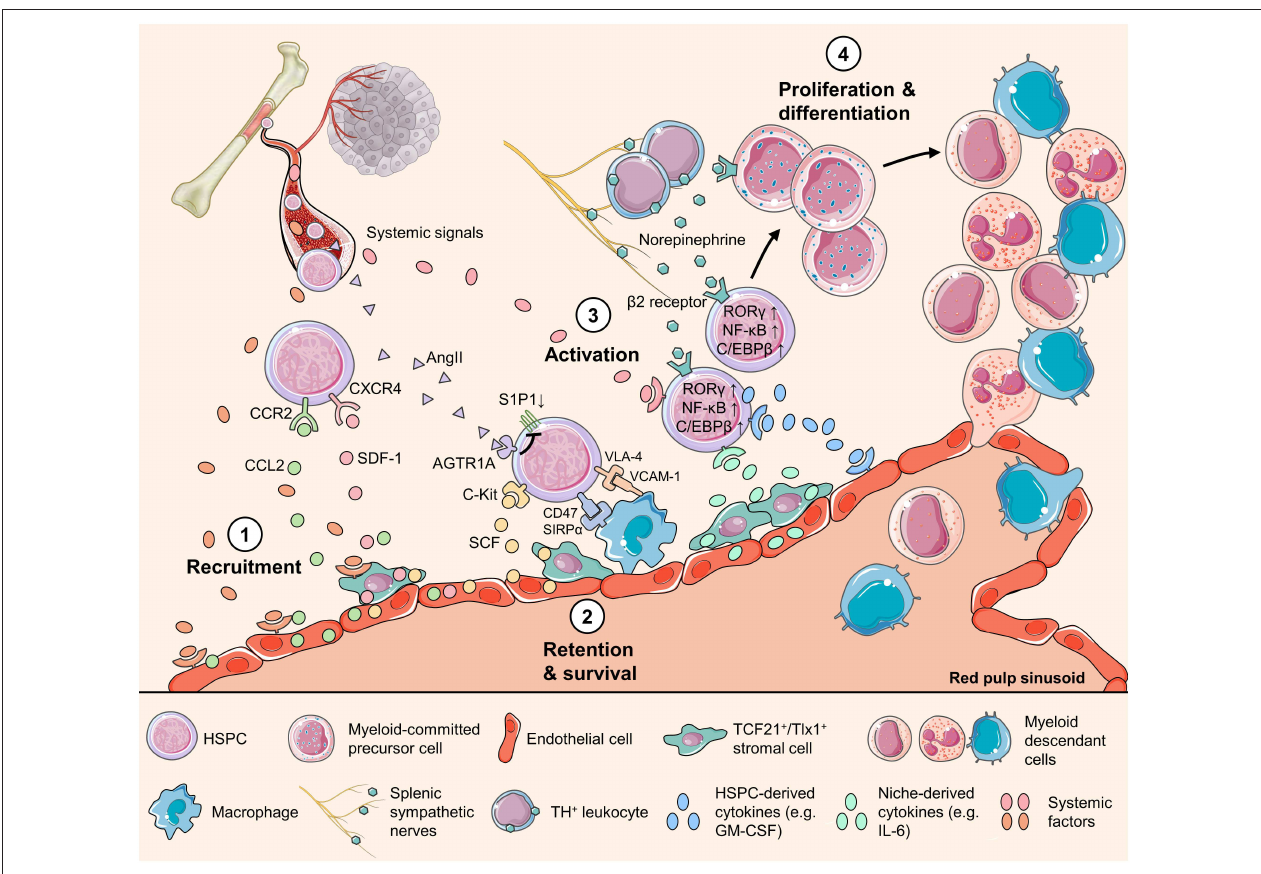
FIGURE 1 | Mechanisms regulating HSPC activity in the spleen. Schematic representation of the HSPC behavior during splenic myelopoiesis, showing multiple cell types and factors of various origins that directly or indirectly regulate HSPC activity. The splenic HSPC response is initiated with (1) increased production of chemokines, such as SDF-1 and CCL2, by endothelial cells and stromal cells around sinusoids. This change of chemokine production might be triggered by systemic factors that convey organismal stress messages. (2) HSPC survival is supported with the key niche-derived cytokine SCF and HSPCs express CD47 to avoid being engulfed by splenic macrophages. In addition, HSPCs express VLA-4 and downregulate S1P1 to maintain in the splenic niche. (3) Activated by systemic, niche-derived, and neural signals, splenic HSPCs upregulate transcription factors including RORC1/ROR γ and C/EBP β to direct myeloid-biased differentiation. Emerging evidence highlights the roles of the HSPC endogenous cytokines such as GM-CSF, and the transcription factor NF- κ B that drives the production of cytokines in HSPC, as key regulators of HSPC behavior. (4) HSPCs proliferate and differentiate into different myeloid cell populations to respond to the body’s or, unfortunately, the tumor’s call. AGTE1A, type1A angiotensin II receptor; AngII, angiotensin II; C/EBP β , CCAAT/enhancer-binding protein β ; CCL2, C-C motif chemokine ligand 2; CCR2, C-C motif chemokine receptor 5; CXCR4, C-X-C motif chemokine receptor 4; NF- κ B, nuclear factor kappa-light-chain-enhancer of activated B cells; ROR γ , related orphan receptor γ ; S1P1, sphingosine-1-phosphate receptor 1; SCF, stem cell factor; SDF-1, stromal-cell-derived factor-1; SIRP α , signal regulatory protein α ; Tlx1, T-cell leukemia homeobox protein 1; VCAM-1, vascular cell adhesion molecule-1; VLA4, very late